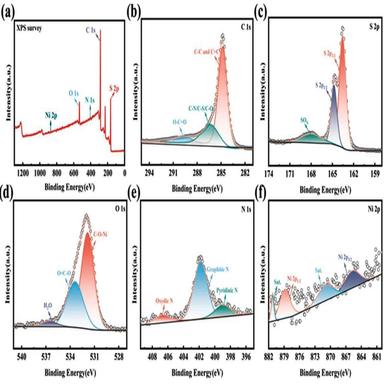
(a)XPS survey of the NiOQDs-2/HCA/S; (b) C 1 s spectra; (c) S 2p spectra; (d) O 1 s spectra; (e) N 1 s spectra and (f) Ni 2p spectra.